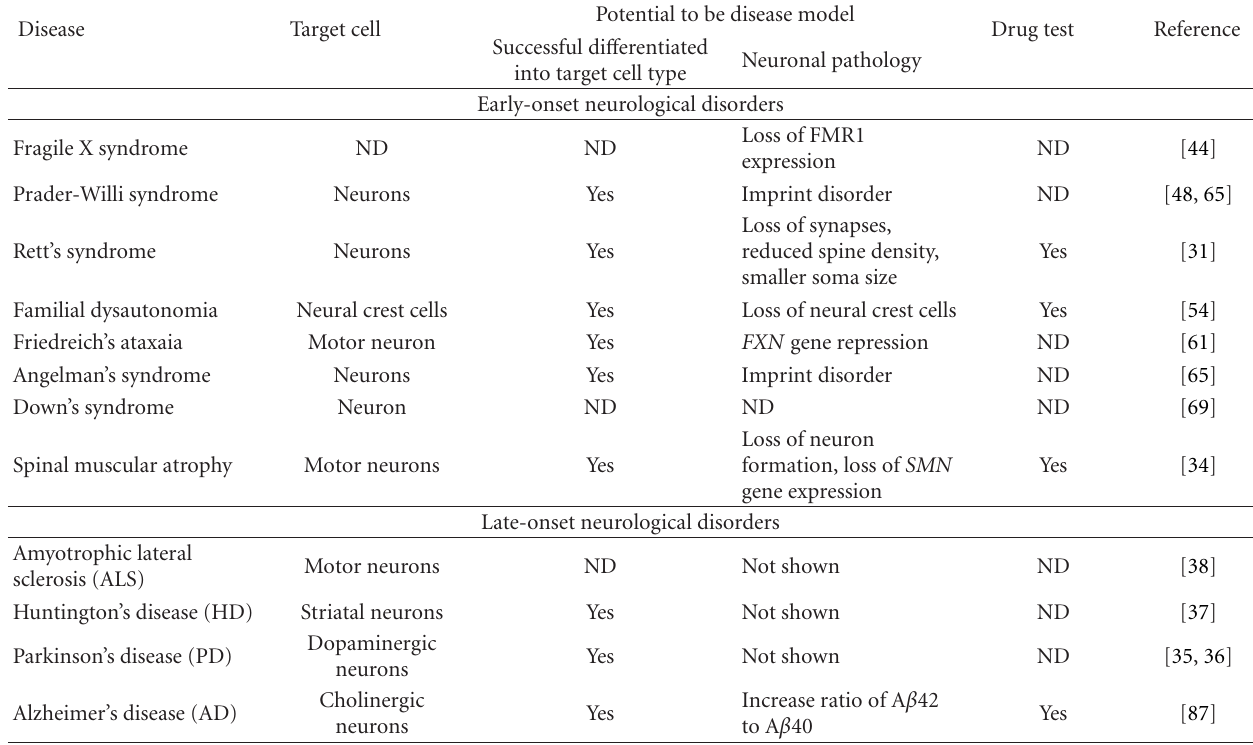
Table 1: List of reported hiPSC disease models.